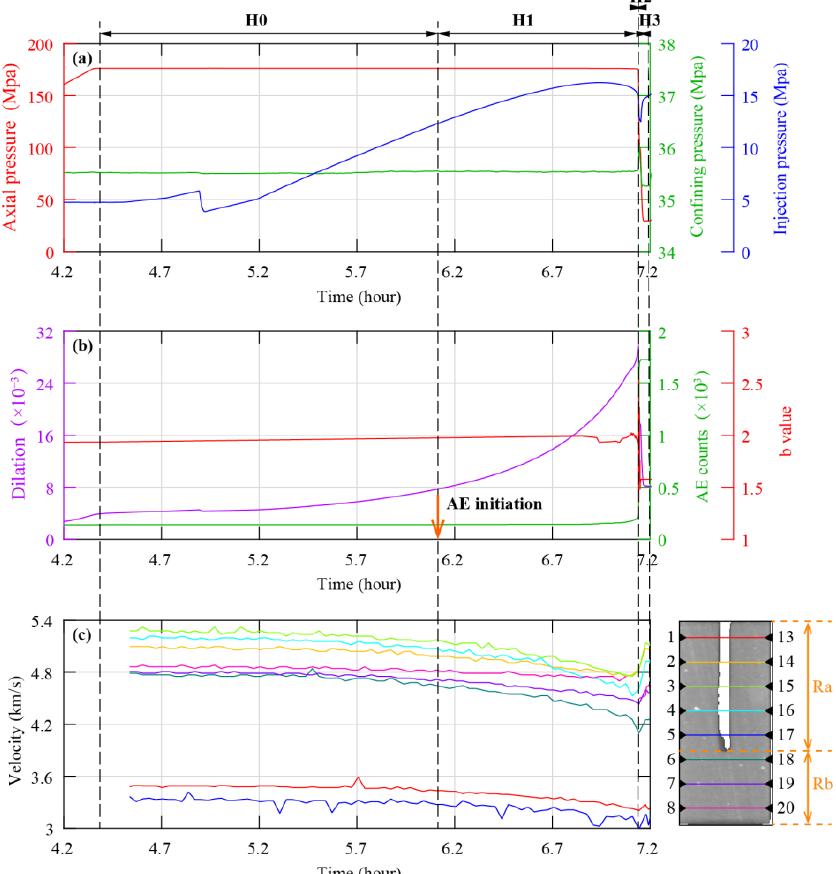
Figure 5. Close-up view of rock loading history (L3 and L4 stages in Figure 3): ( a ) pressure; ( b ) volumetric dilation, the cumulative AE number, and change in b-value; ( c ) change in ultrasonic velocities (different colors represent different paths). According to water injection pressure and the time distribution of acoustic emission, the experiment at this stage can be roughly divided into four phases: pore pressure increasing phase (H0), pre-fracture phase (H1), fracture nucleation phase (H2), and post-fracture phase (H3). The black dotted lines represent the boundaries of the